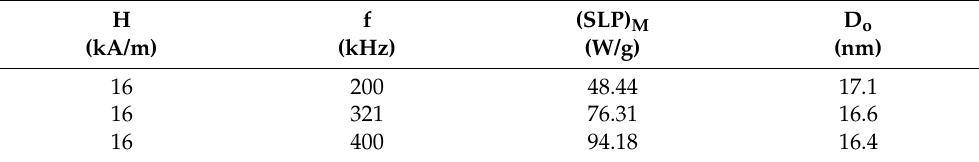
Table 4. The values of the maximum specific loss power (SLP) M and the nanoparticle diameter (D o ) corresponding to (SLP) M for three frequencies in the case of mobile